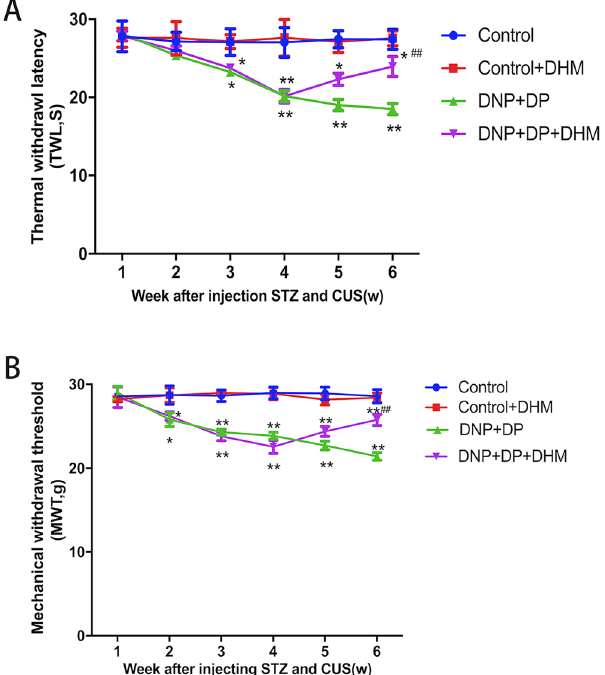
Figure 1. Effects of dihydromyricetin on the thermal withdrawal latency (TWL) ( A ) and mechanical withdrawal threshold (MWT) ( B ) of rats with comorbid DNP and DP. Values are the mean ± SEM of 6 observations. * p < 0.05 and ** p < 0.01 vs . control group; ## p < 0.01 vs. DNP + DP